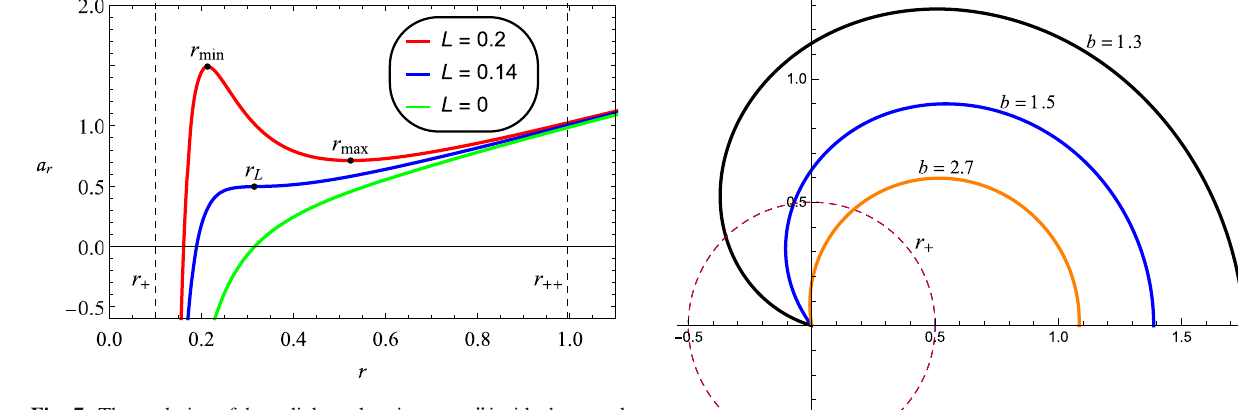
Fig. 7 The evolution of the radial acceleration a r ≡ ¨ r inside the casual region r + < r < r ++ plotted for Q = 0 . 2, λ = 1 and three different values of L . The case of L = 0 . 2 has two extremums at r min ≈ 0 . 21 and r max ≈ 0 . 52. The case of r min = r max = r L happens for L = 0 . 14 where r L ≈ 0 . 31